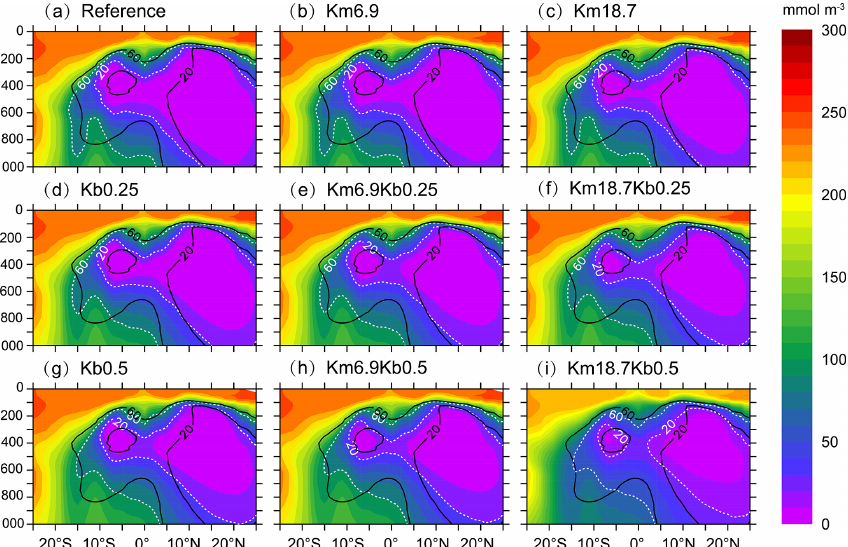
Figure 4. Vertical distribution of DO concentration over 120–90 ◦ W from different model simulations: (a) the reference run, (b, c) with a reduced O : C utilization ratio, (d, g) with an enhanced vertical mixing, and ( e, f, h, i ) the combination of a reduced O : C utilization ratio and an enhanced vertical mixing. Black lines denote contours of DO concentrations of 20 and 60mmolm − 3 from WOA2013 data. Table 1. Bias and root mean square error (RMSE) for DO (mmolm − 3 ) comparisons between WOA2013 and model simulations averaged over 1991–2010 in the eastern tropical North Pacific (ETNP) and eastern tropical South Pacific